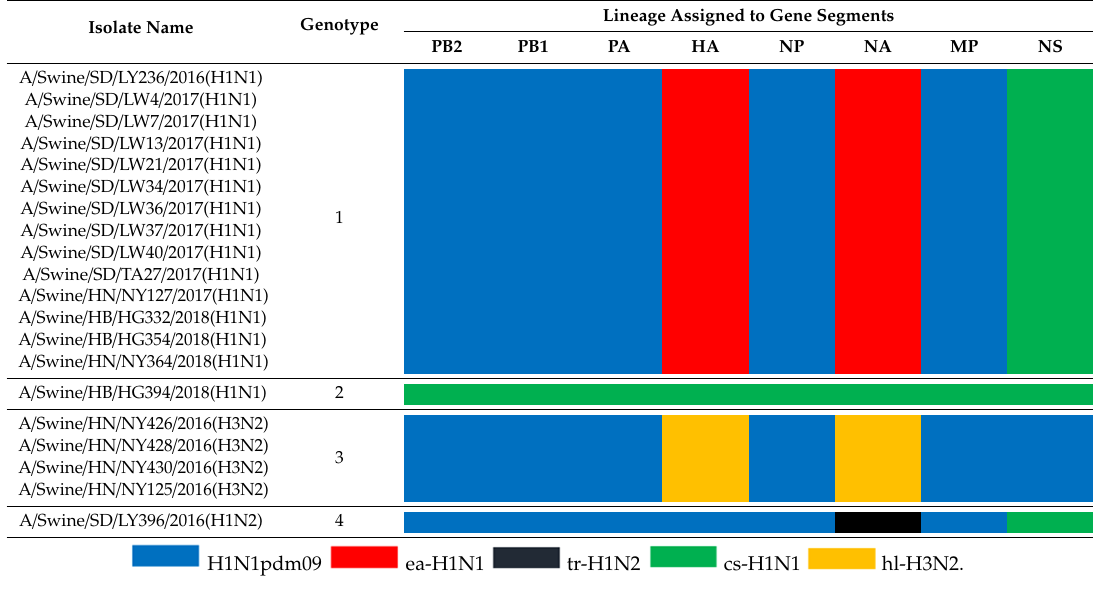
Table 2. The genotypes of all isolates.